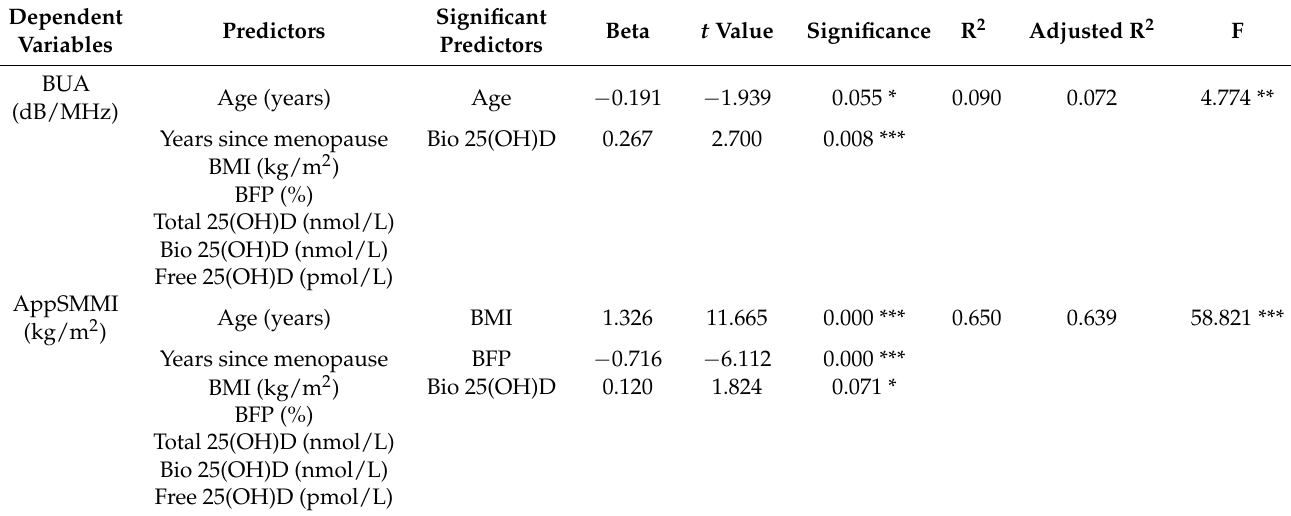
Table 5. Stepwise regression analyses of vitamin D indices with bone density (BUA) and appendicular skeletal muscle mass index (appSMMI).